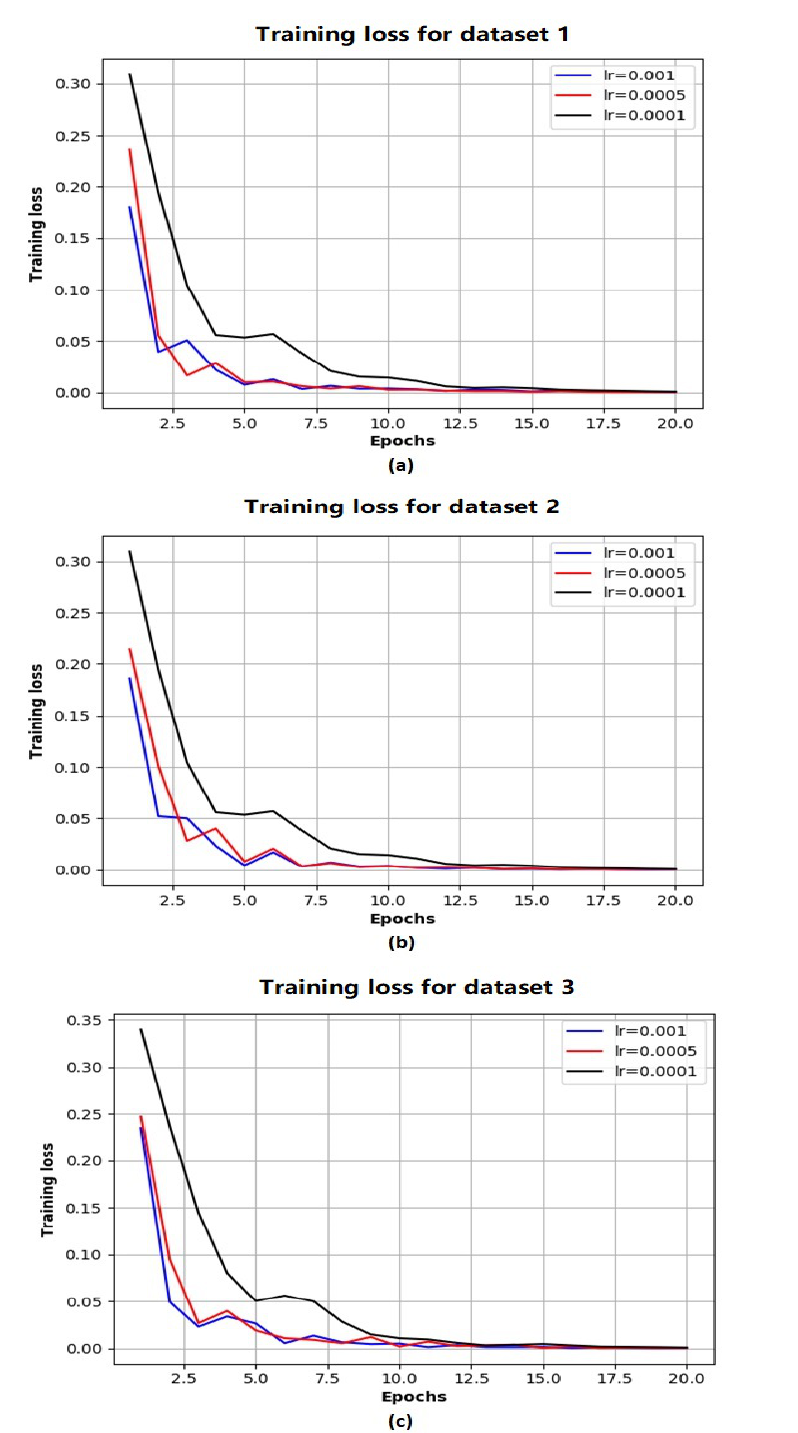
Figure 4. The evolution of MSE losses with training epoches with respect to Dataset 1 ( a ) Dataset 2 ( b ) Dataset 3 ( c